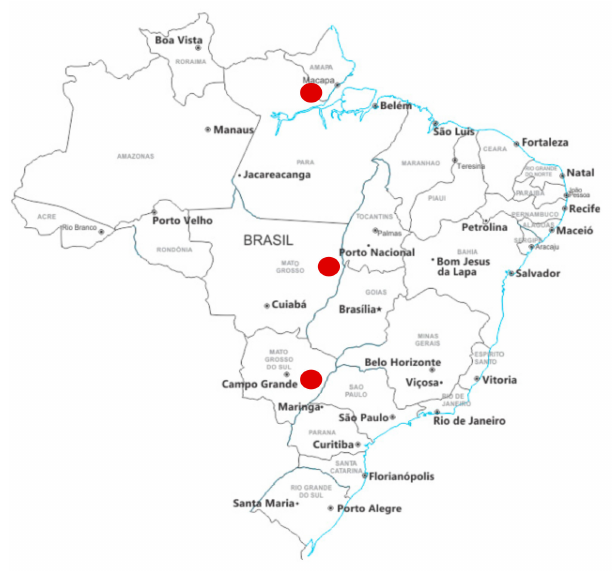
Figure 1. Location of the cities considered in this study.